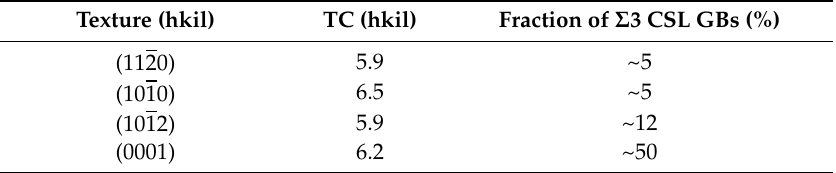
Table 6. Fraction of Σ 3 CSL GBs in textured α -Al 2 O 3